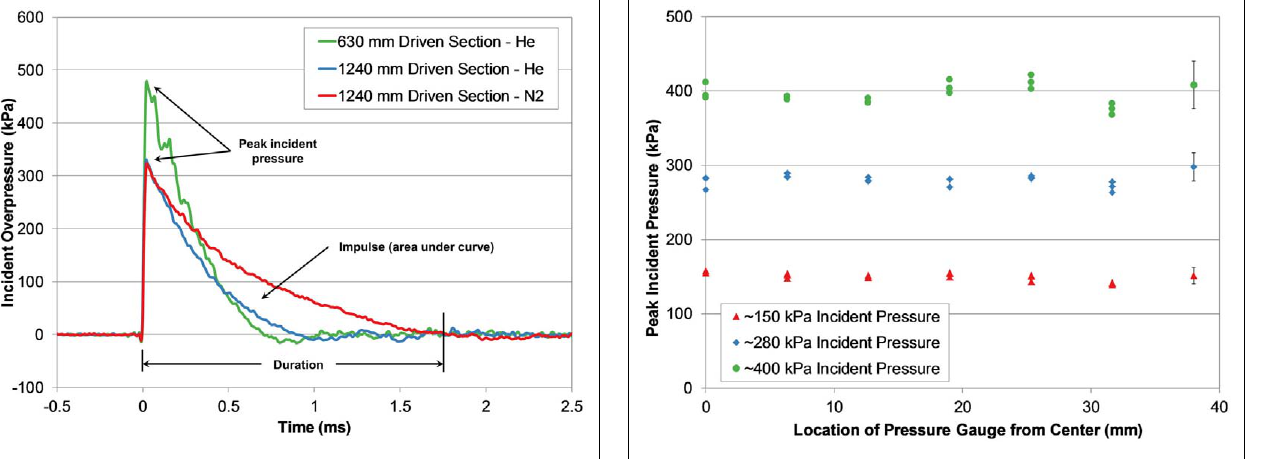
FIGURE 4 | Comparing incident pressure time-histories measured at the end of the shock tube for three different shock tube configurations with the same burst pressure (4200kPa).